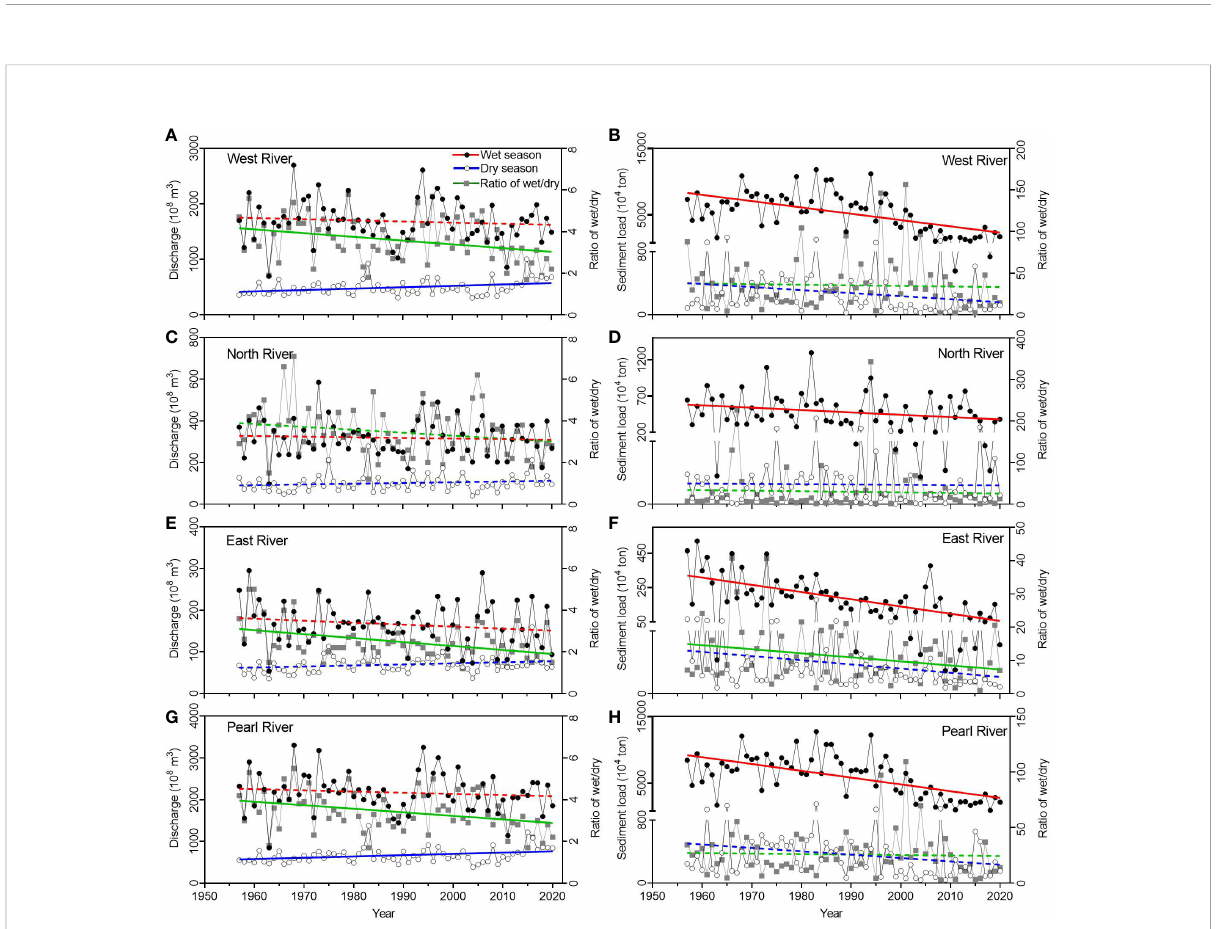
FIGURE 5 Temporal changes of discharge and sediment load in wet and dry-season, and the ratio of wet to dry seasons in the West (A, E) , North (B, F) , East (C, G) Rivers, and the Pearl River (D, H) since the 1960s. Solid lines denote signi fi cant correlations ( P ≤ 0.05), whereas dotted lines denote non-signi fi cant